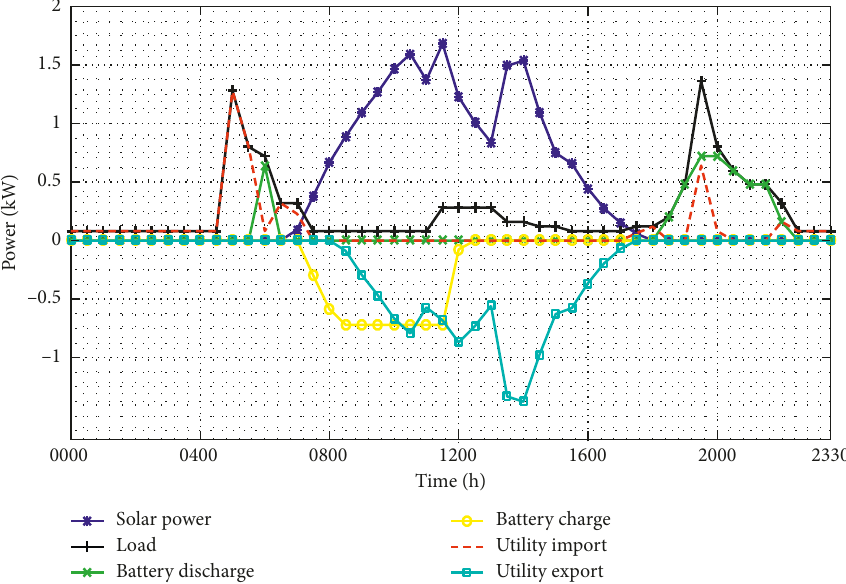
Figure 9: Power source operation for the rule-based algorithm. Table 4: Cost function value